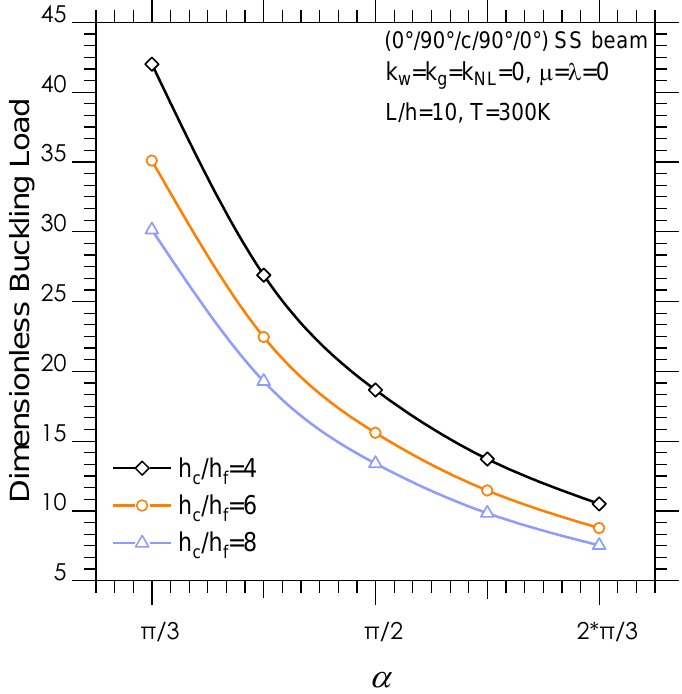
Figure 4. Dimensionless buckling load versus opening angle.